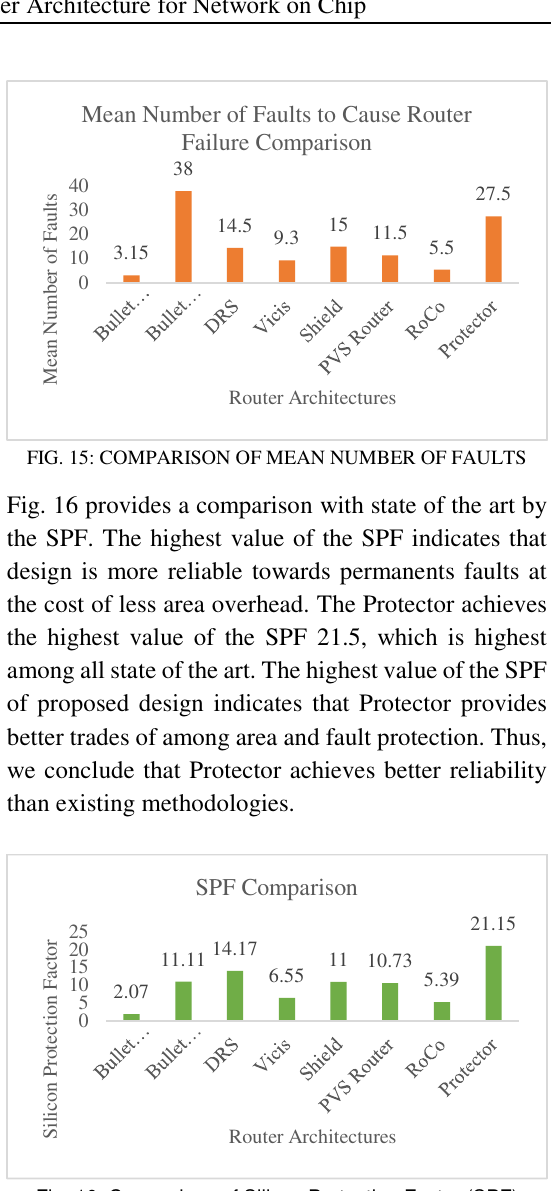
Fig. 16: Comparison of Silicon Protection Factor